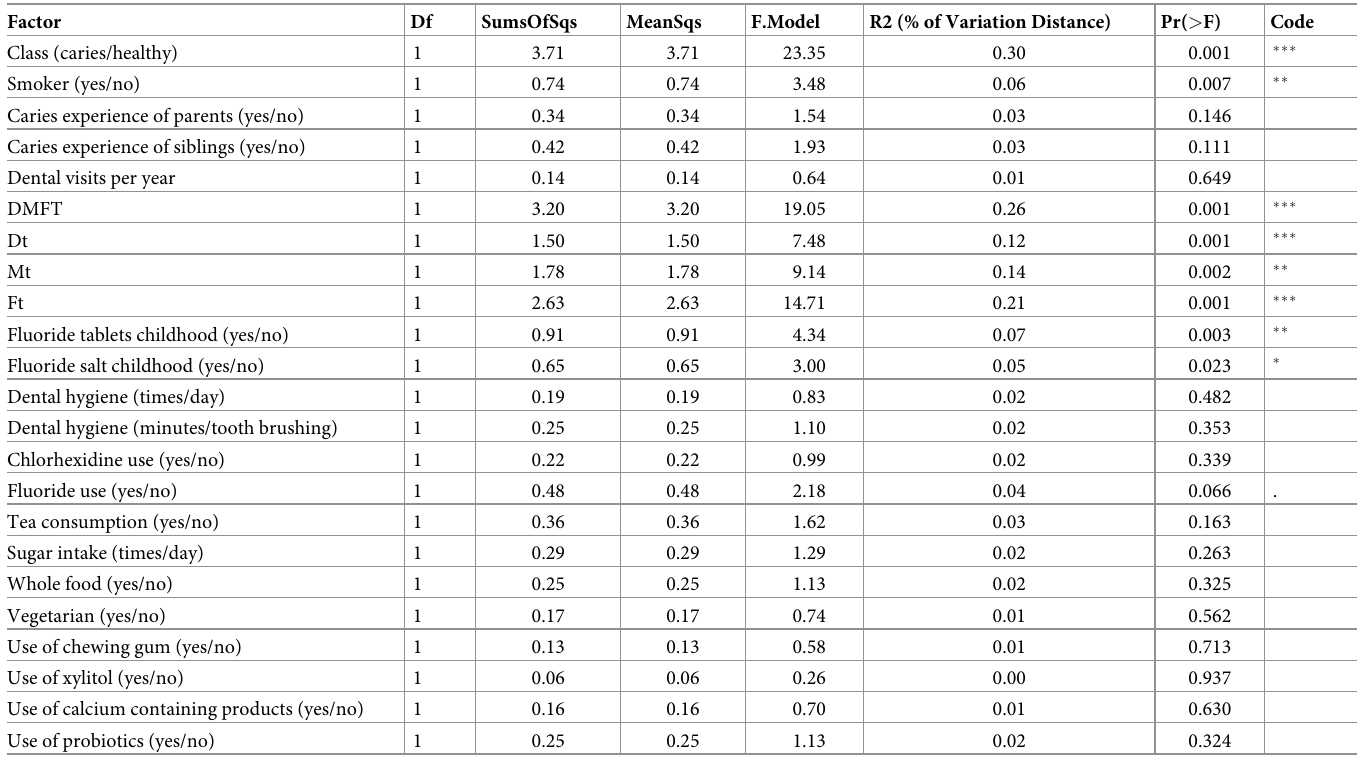
Table 2. Descriptive statistics.